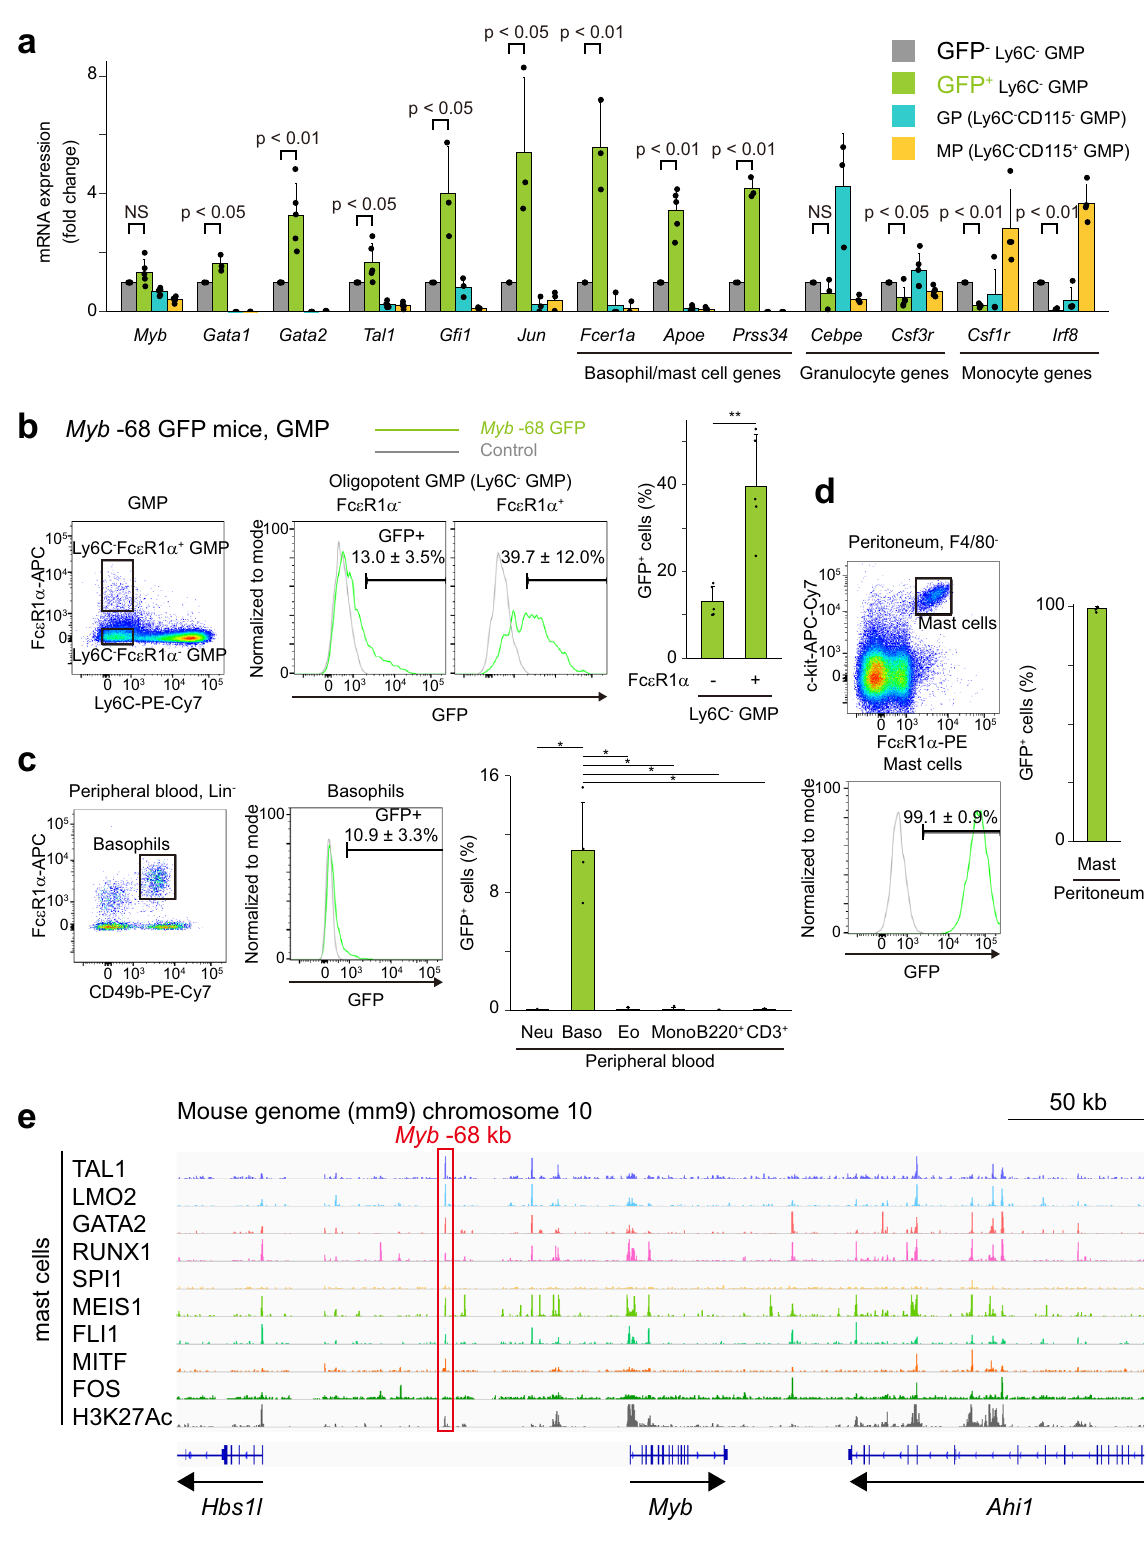
onset of Fc ε R1 α surface expression (Fig. 4). FACS-sorted GFP - and GFP + Fc ε R1 α - Ly6C - GMPs were cultured with GM-CSF or IL-3. Indeed after 3 days under both culture conditions, GFP + Fc ε R1 α - Ly6C - GMPs gave risetomorebasophilsthanGFP - Fc ε R1 α - Ly6C -